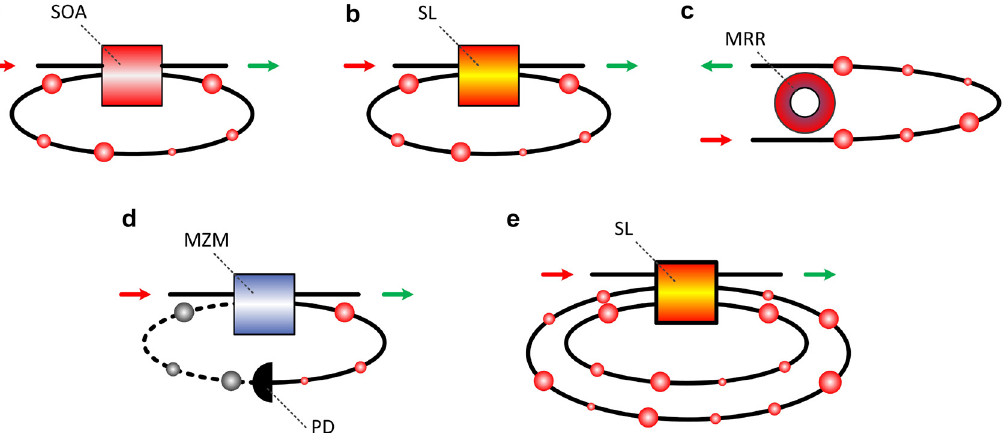
Figure2: All-opticalandoptoelectronictopologiesthatareusedinreservoircomputingwithasinglerealnodeandfeedbackloops,foroptical information processing. All-optical systems that exploit the nonlinear operating regime of (a) semiconductor optical ampli fi er (SOA), (b) semiconductor laser (SL), and (c) microring resonator (MRR) with single external optical delay. Optoelectronic systems (d) that exploit the nonlinearity of Mach – Zehnder modulators (MZM) in presence of an optical and electrical delay, including optoelectronic conversion. (e) SL with multiple optical delays. PD: photodetector. Straight connection line: optical paths. Dashed connection line: electrical